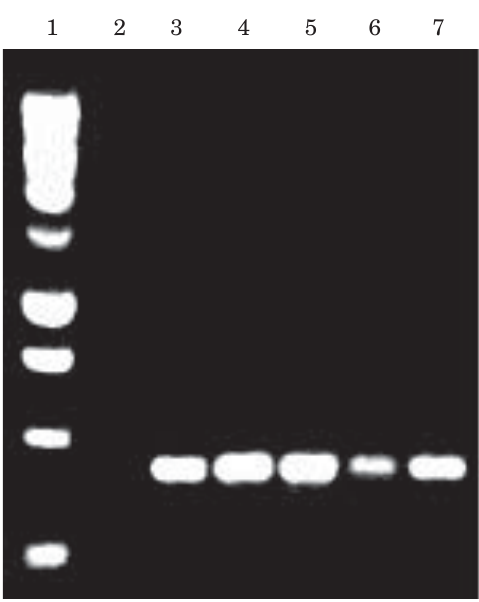
Fig. 1. Agarose gel electrophoretic analysis of the coat protein gene of grapevine virus A amplified by IC-RT- PCR using the primer pair H587/C995. Aliquots (5 µl) of the PCR products were analyzed in a 1% agarose gel. Lane 1, 1-Kb DNA size marker; lane 2, negative control; lanes 3–7, symptomatic field samples.